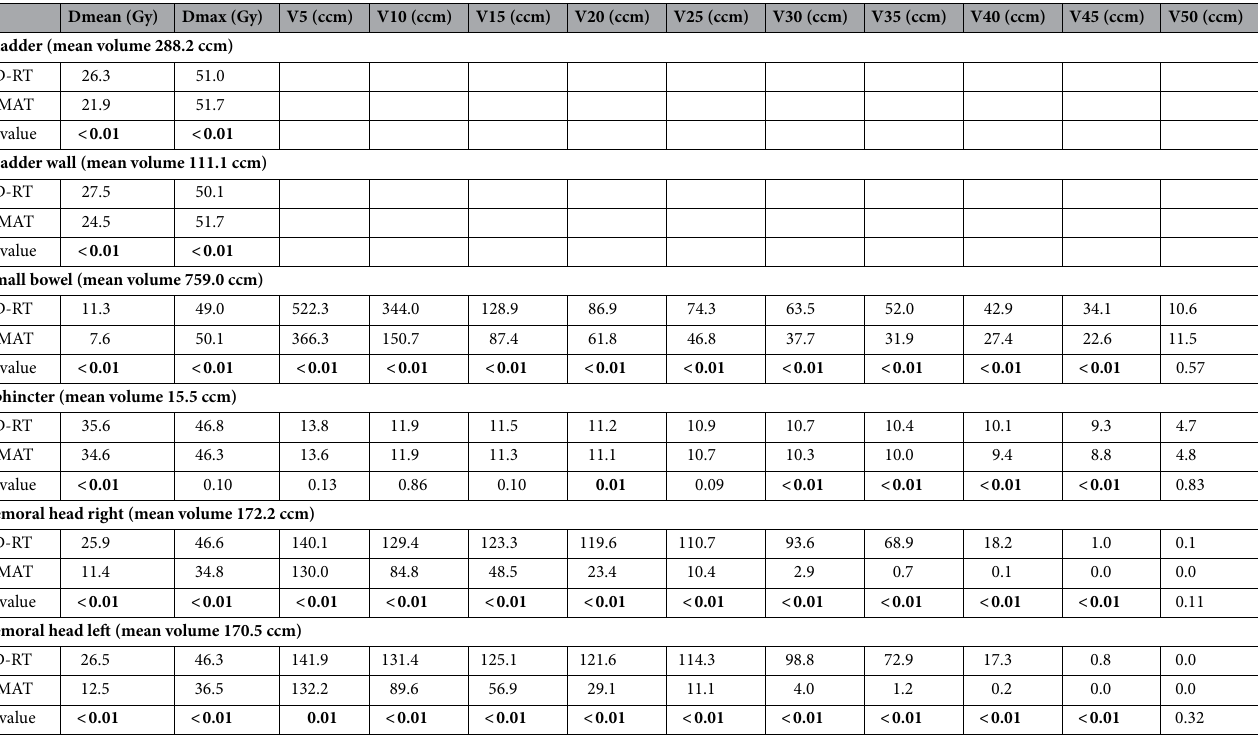
Table 3. Dose-volume parameters for 3D-RT and VMAT plans. Stated values are shown as mean values. Statistical analysis was performed using Wilcoxon signed rank test. A p-value < 0.05 was considered